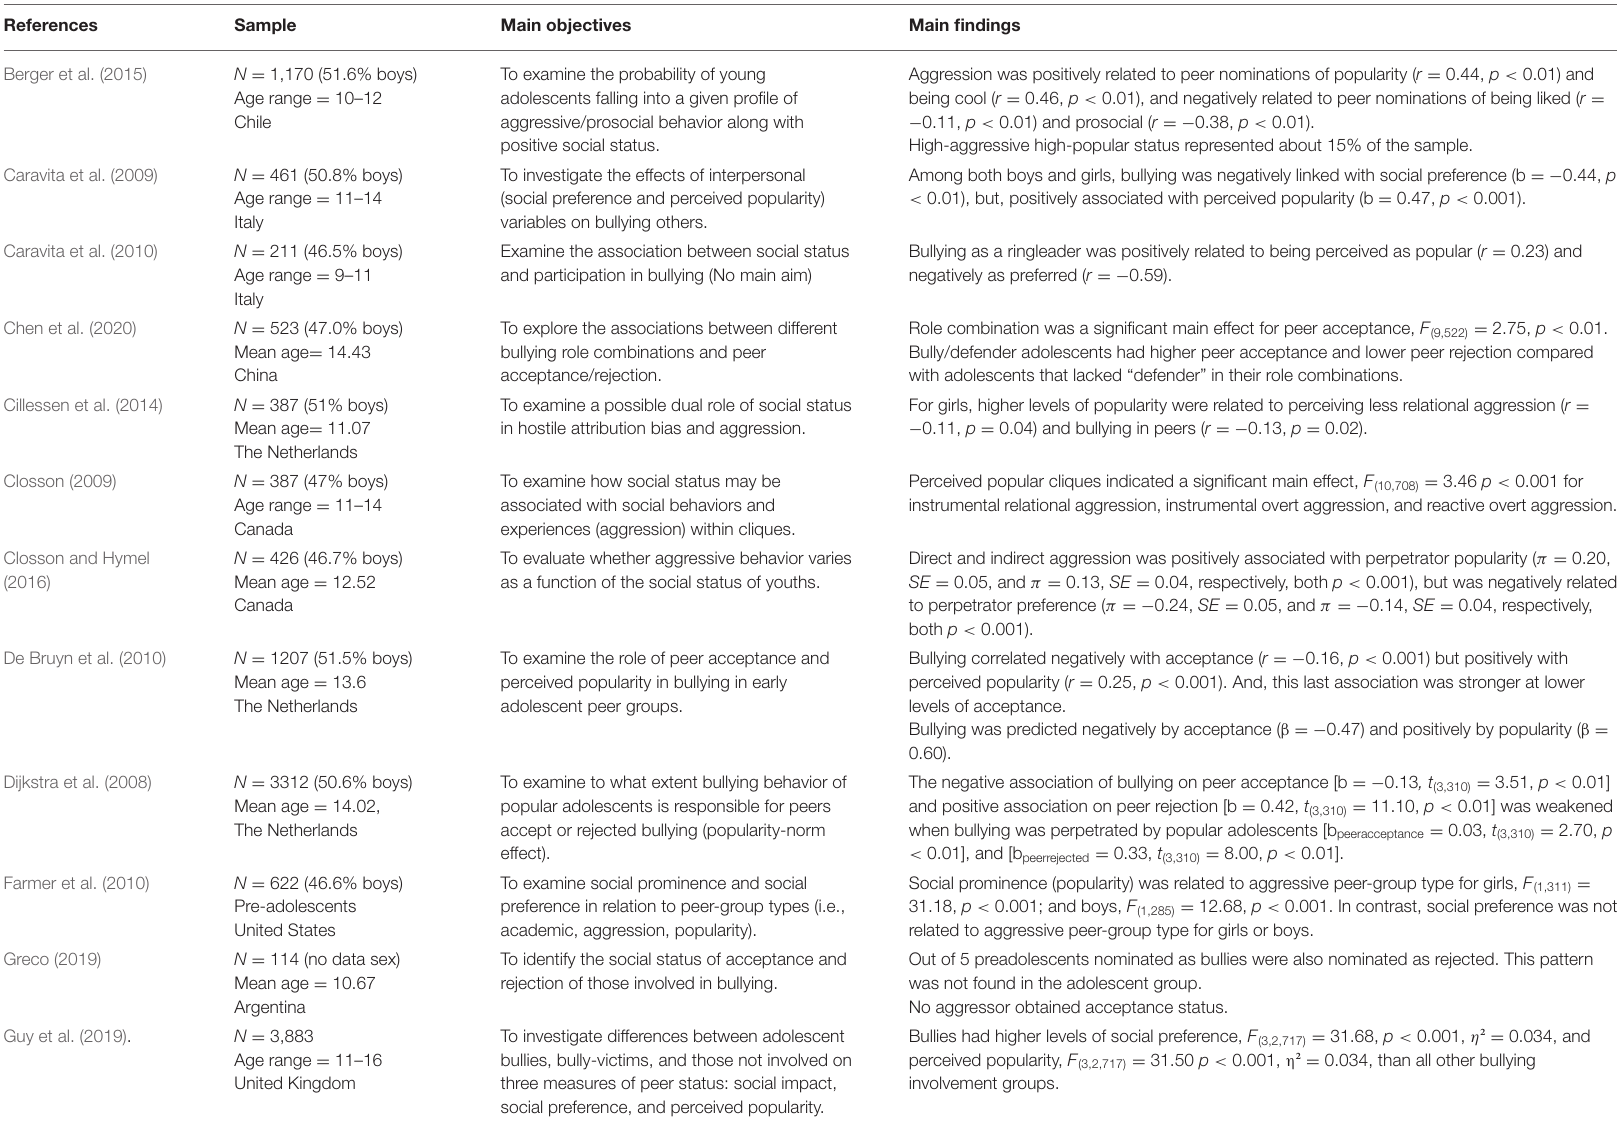
TABLE 2 | Summary of selected